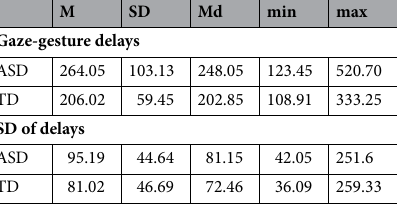
Table 2. Descriptive statistics of the IaPS measurements. All values given in ms. Descriptive statistics for groups were retrieved from participant-wise aggregated